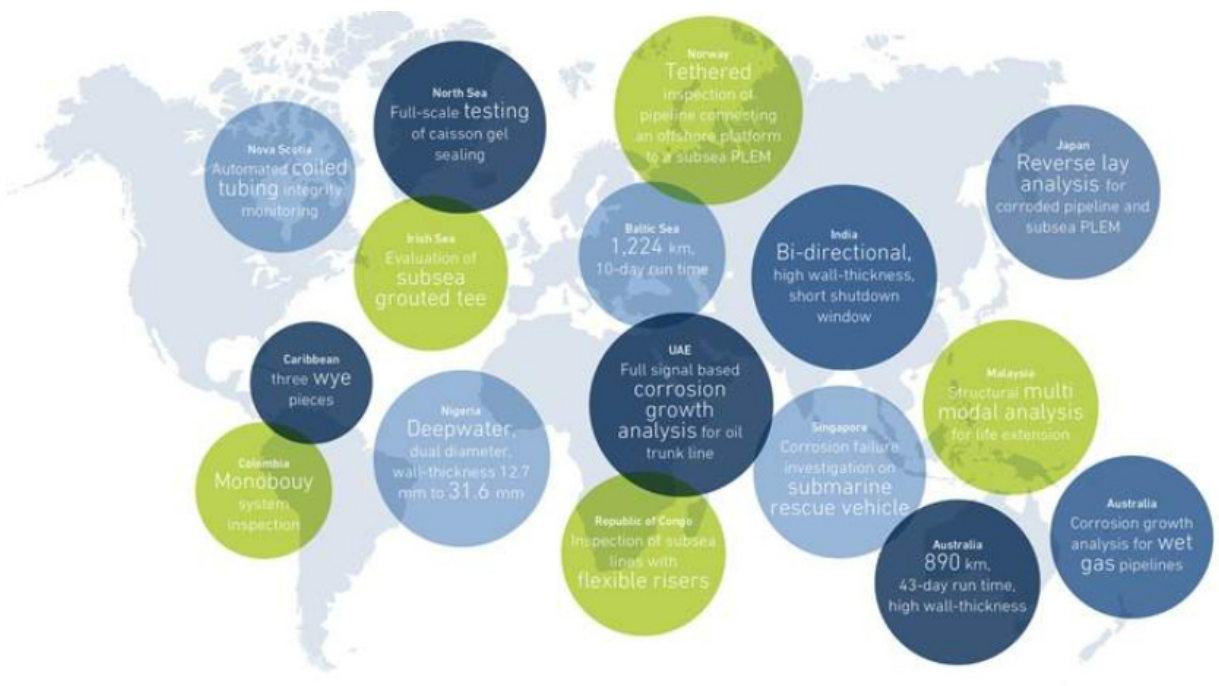
Figure A2. Map of breakdown of FPSO projects by geographical zones, showing various assets that are monitored; from FPSO Asia as of 2013 .